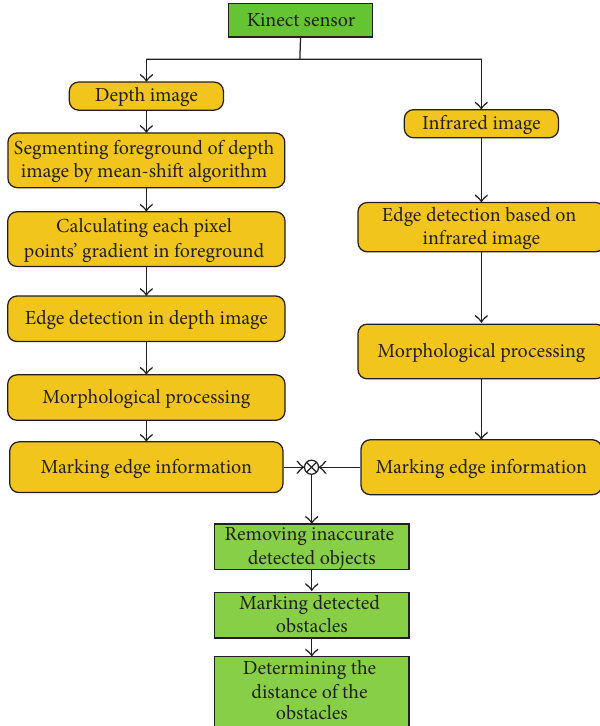
Figure 5: Block diagram of detection